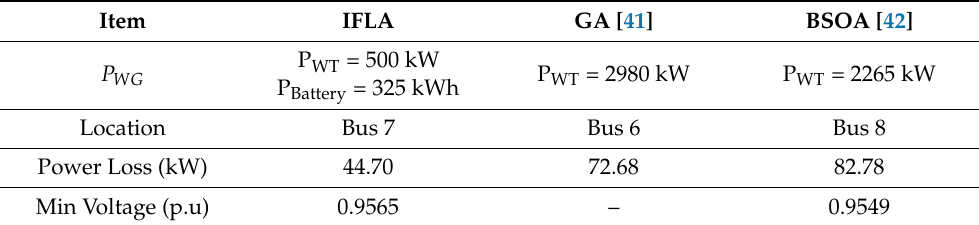
Table 10. Comparison with past